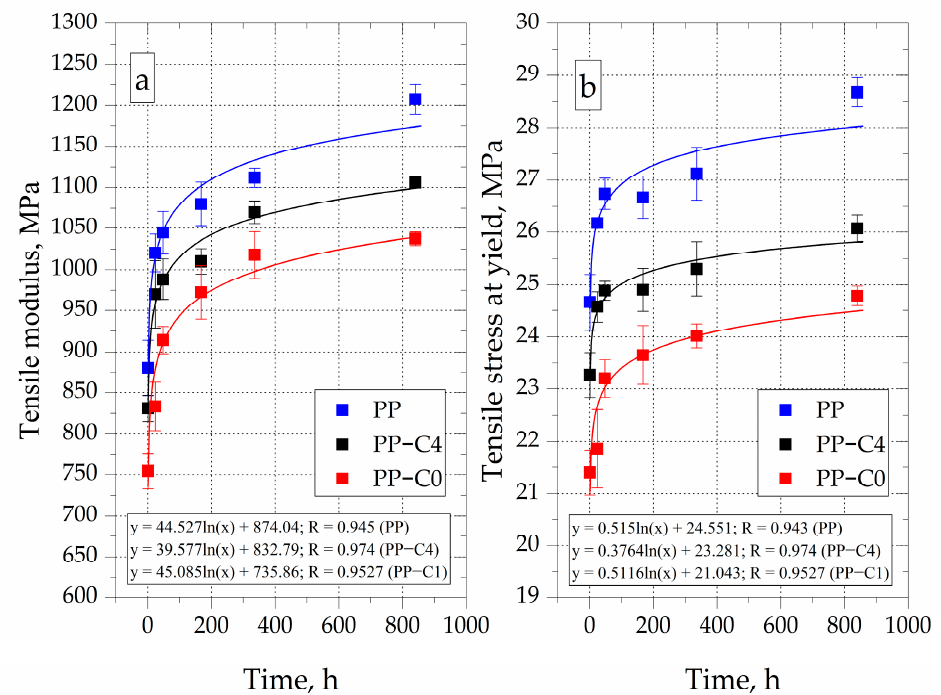
Figure 8. Changes of tensile modulus ( a ) and tensile stress at yield ( b ) as a function of the conditioning time .